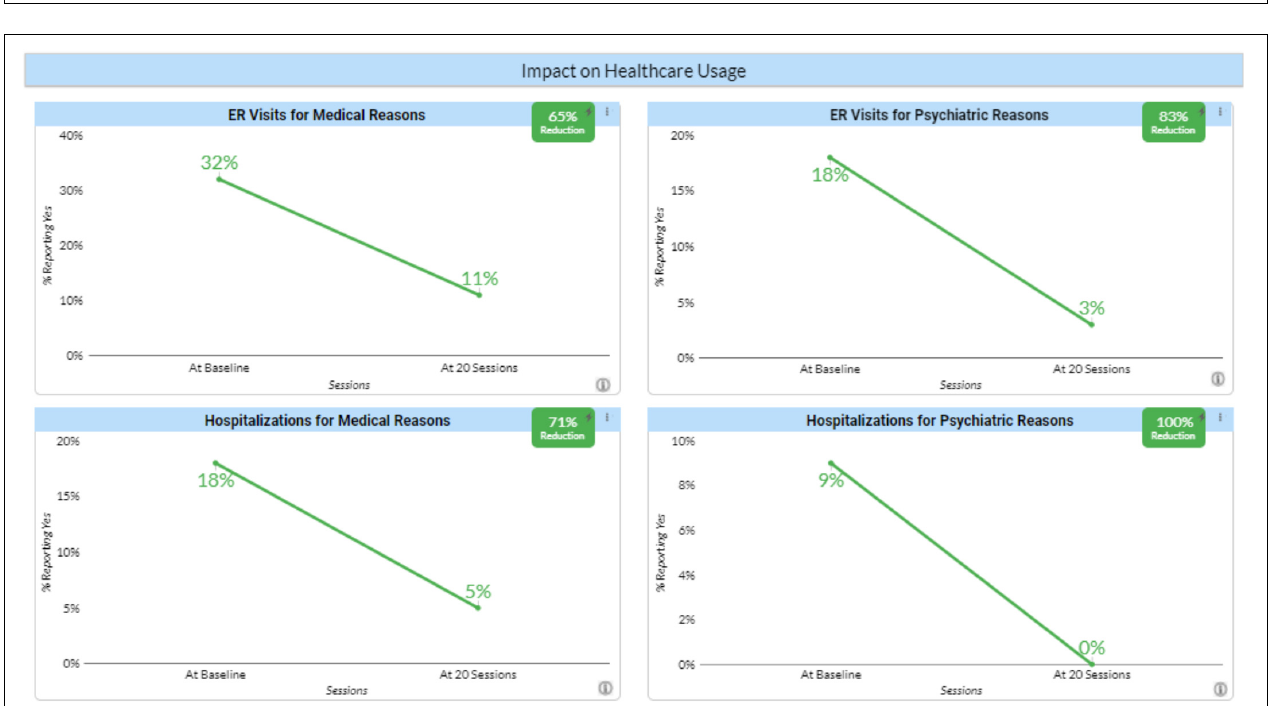
FIGURE 4 | Impact of neurofeedback on healthcare usage. Percentages of clients reporting emergency room visits or hospitalizations for either medical or psychiatric reasons before and after 20 neurofeedback sessions.